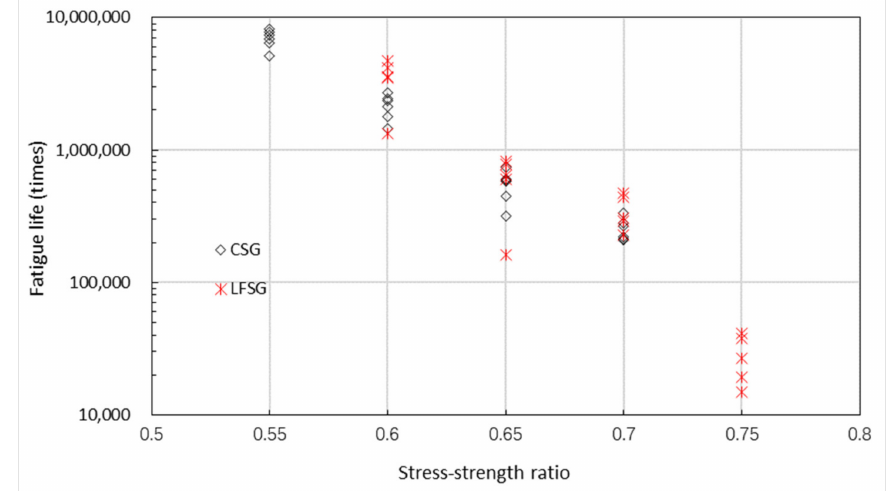
Figure 8. Fatigue life of CSG and LFSG in different stress–strength ratios.